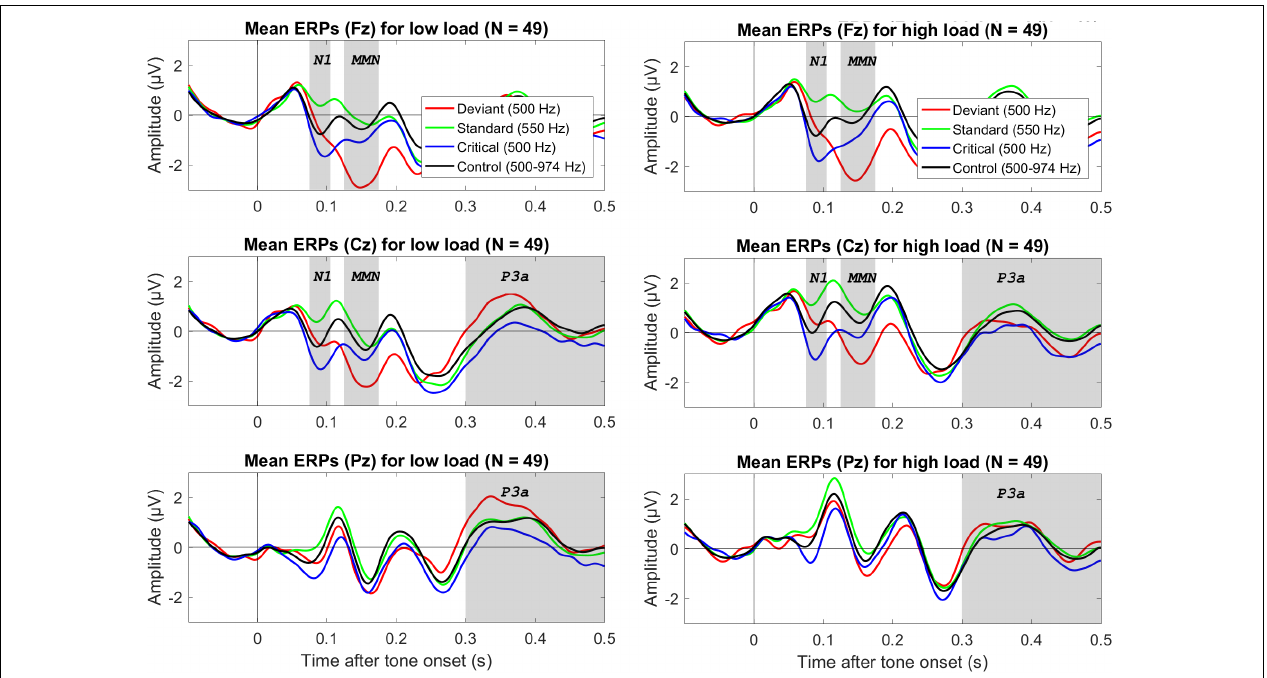
FIGURE 1 | Grand average ( N = 49) ERPs to the onset of different tones for three electrodes (in different rows), separately for low visual load (left column) and high visual load (right colum). The deviant and standard were from the oddball condition, the critical tone was identical to the deviant but from the control condition, and the control tone refers to all tones in the control condition. The gray bars mark the relevant electrodes and intervals for the N1, MMN, and P3a. The data were low-pass filtered at 30